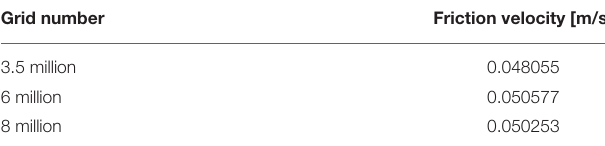
TABLE 4 | Mesh sensitivity